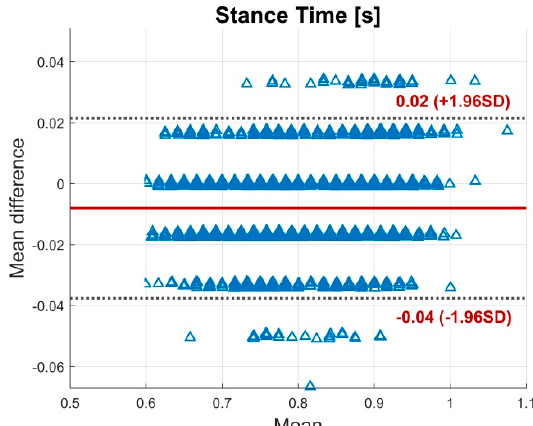
Figure A5. BA plot for the stance time. The plot contains all calculated data points of all subjects. The solid line indicates the mean difference. The dashed lines indicate the LoA (95% CI of the mean difference).